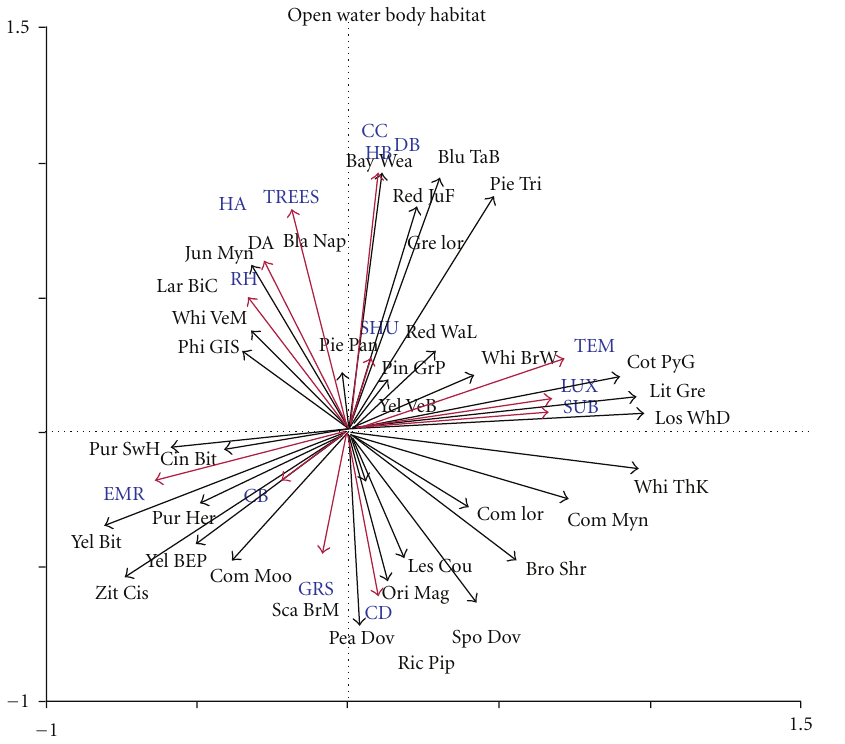
Figure 4: Ordination plot from a redundancy analysis of the distribution of birds of open water body in relation to 14 environmental variables (for details see Table 2). The biplot of axes 1 and 2 is presented; the orientation of each variable in relation to each of these axes is presented by an arrow, the length of which indicates the degree of correlation with those